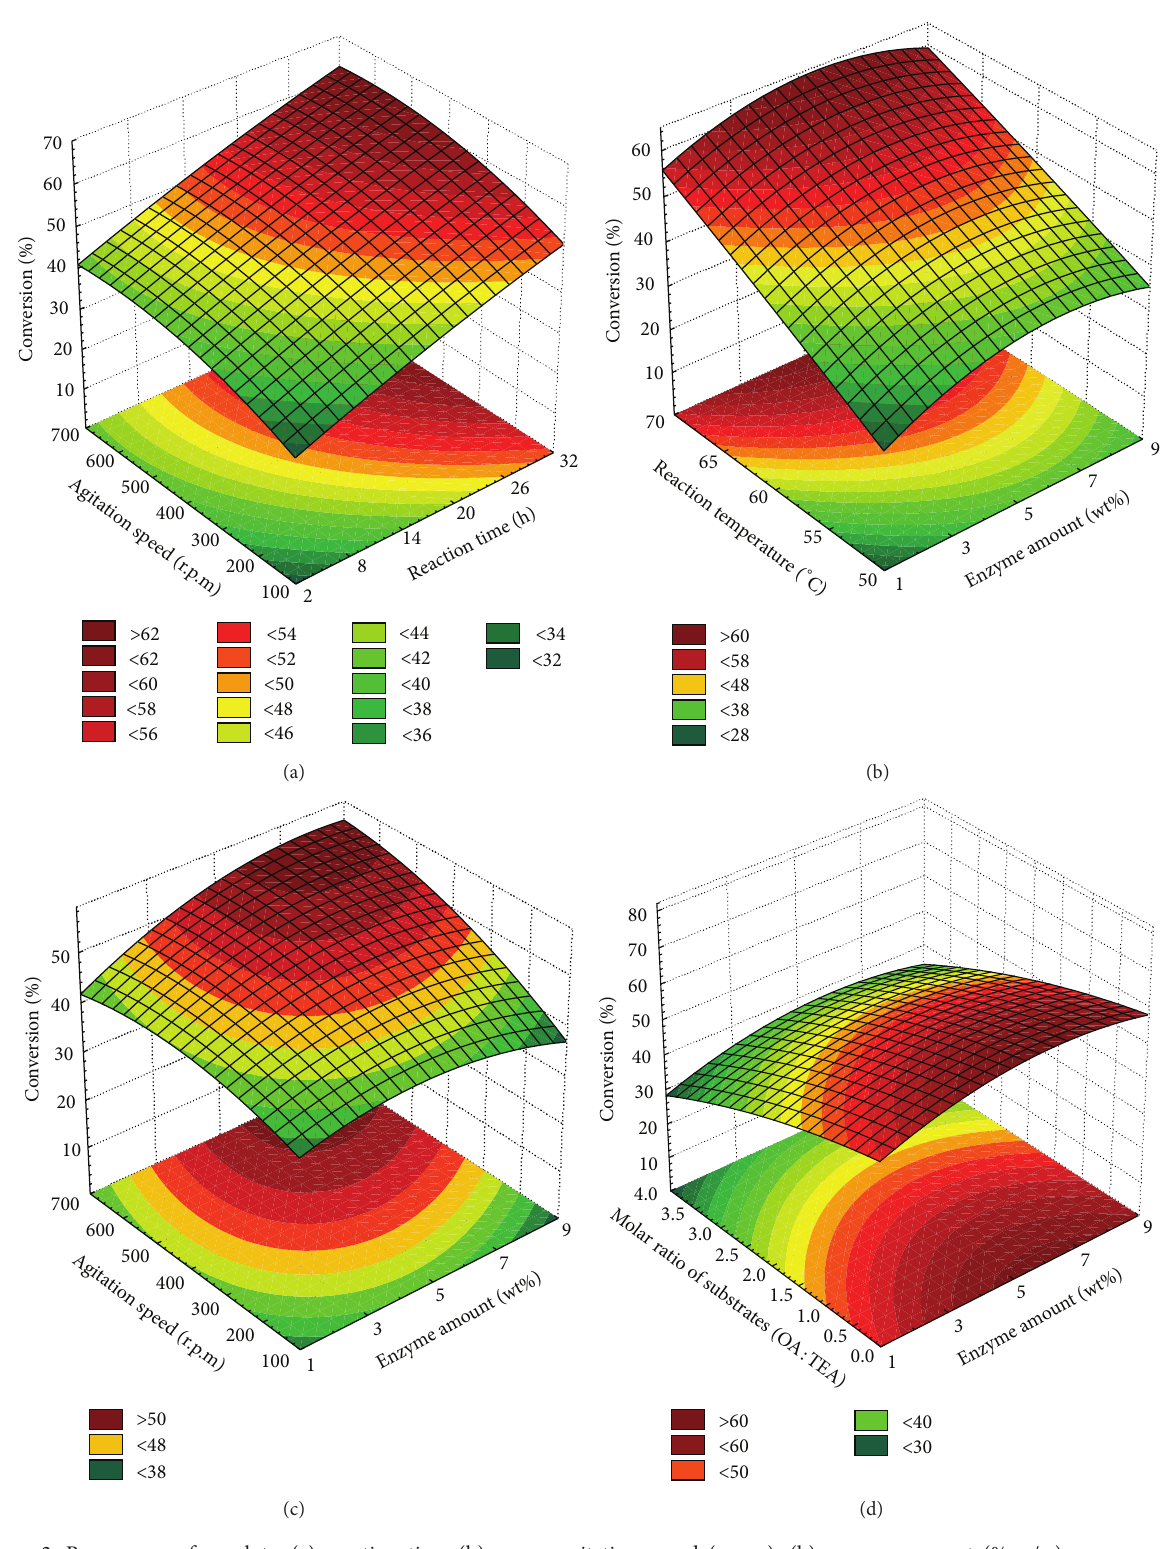
Figure 2: Response surface plots: (a) reaction time (h) versus agitation speed (r.p.m.); (b) enzyme amount (% w/w) versus reaction temperature ( ∘ C); (c) enzyme amount (% w/w) versus agitation speed (r.p.m.); (d) enzyme amount (% w/w) versus molar ratio of substrates (OA:TEA) (mole) on percentage conversion as